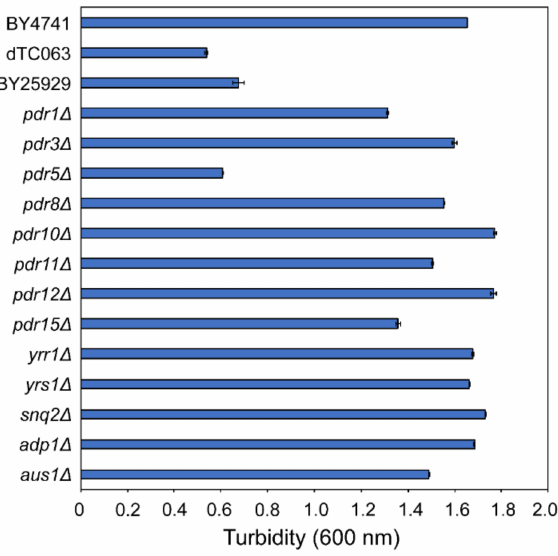
Figure 3. Susceptibility to nagilactone E in S. cerevisiae mutants lacking genes associated with multidrug resistance. BY4741, dTC063, and BY25929 are parental, 13 multi-gene-deficient, and double gene- deficient ( pdr1 ∆ pdr3 ∆ ) strains, respectively. Exponentially growing cells were grown at 30 ◦ C with 72 h shaking in 2.5% ME with 250 µ M nagilactone E. Data are expressed as the mean ± standard deviation (n =